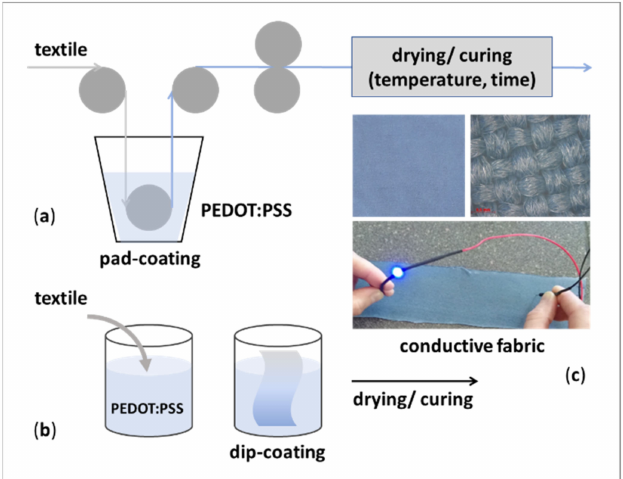
Figure 2. Schematic presentation of: ( a ) A continuous coating process; ( b ) A discontinuous coating process; and ( c ) A photo and optical microscopic image of poly-3,4-ethylenedioxythiphene: